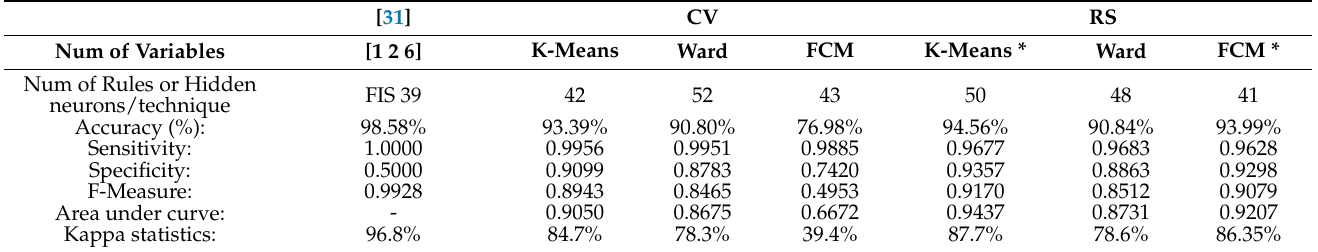
Table 7. Performance metrics obtained with our proposed framework compared with results obtained by [31].